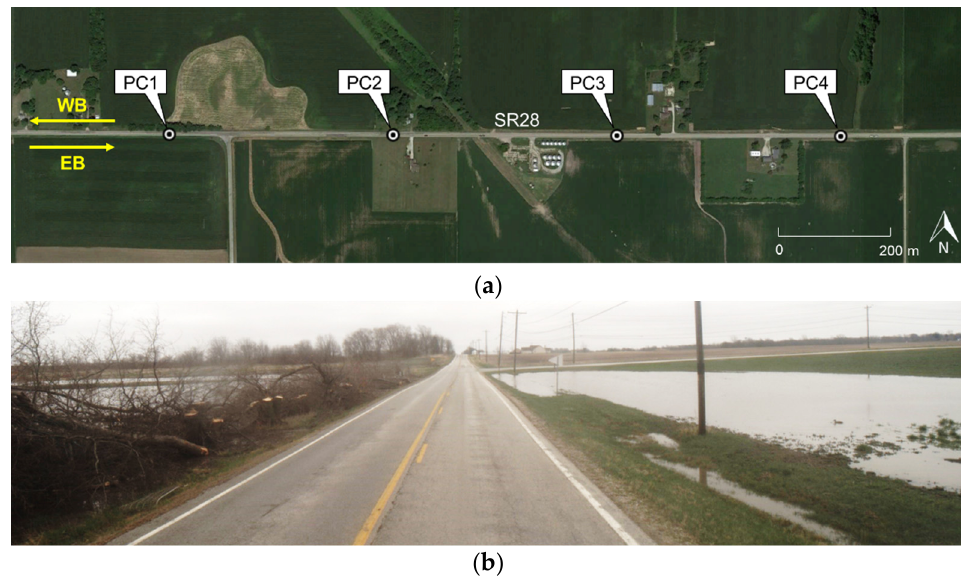
Figure 4. Study site at SR28: ( a ) the one-mile-long region of interest and cross-section locations PC1 , PC2 , PC3 , and PC4 (aerial photo adapted from a Google Earth Image), and ( b ) image of the surveyed area at location PC1 captured by one of the cameras onboard the PWMMS-HA.